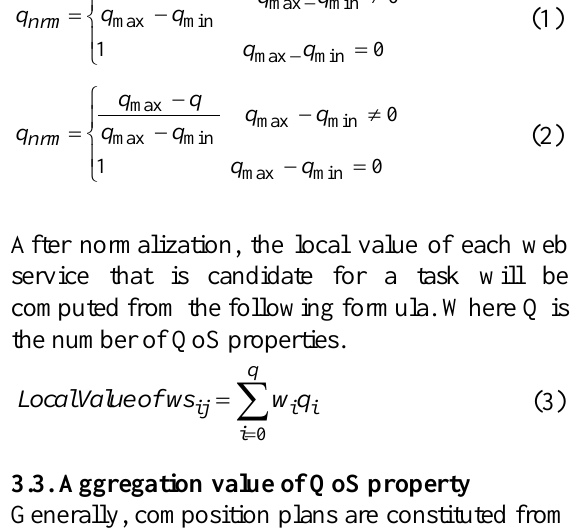
Figure 5. A cycle pattern.